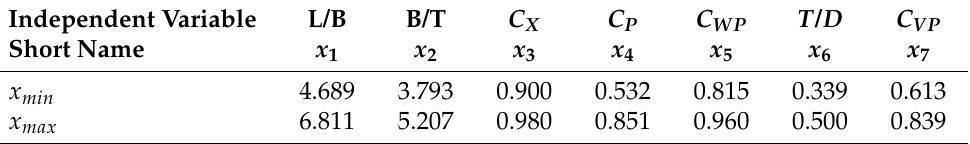
Table 3. Primitive variables for